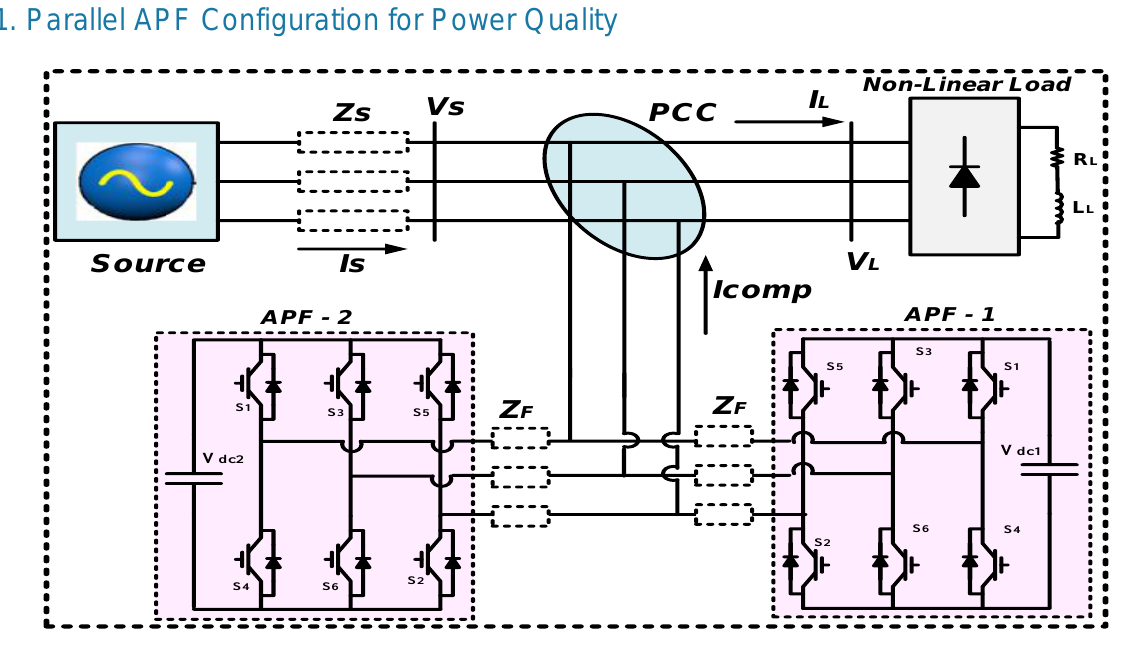
Figure 5. Parallel APF in power